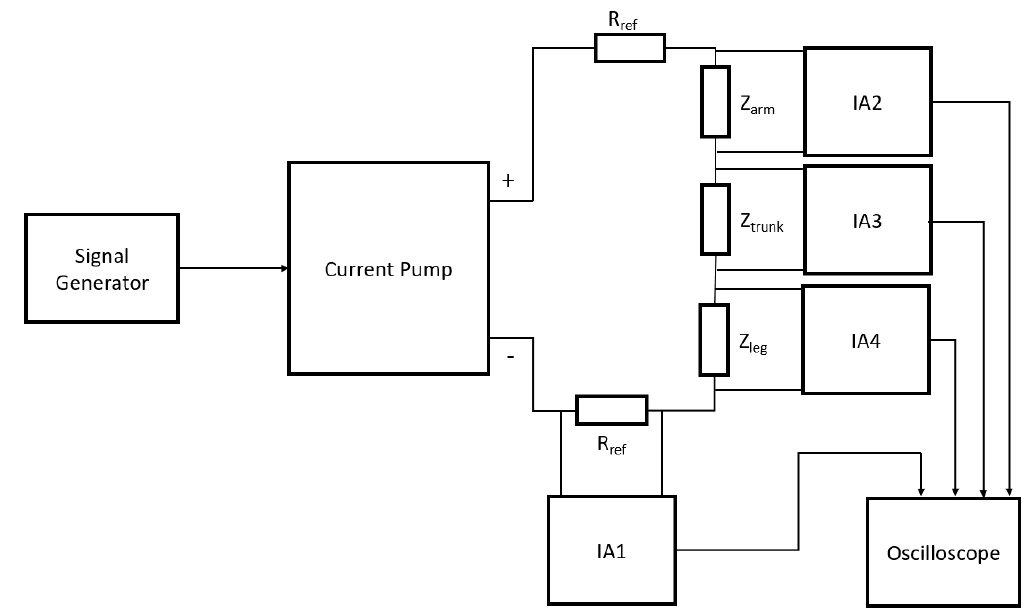
Figure 2. Block diagram for segmental measurements. IA—instrumentation amplifier.